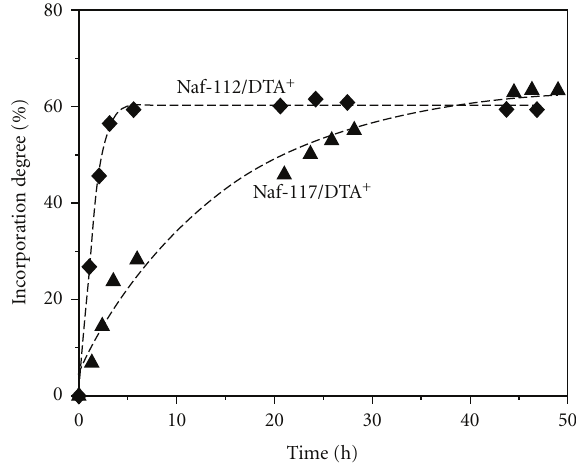
Figure 1: Time dependence of DTA + incorporation into the struc- ture of ( (cid:2) ) Nafion-112 membrane and ( (cid:3) ) Nafion-117 membrane.